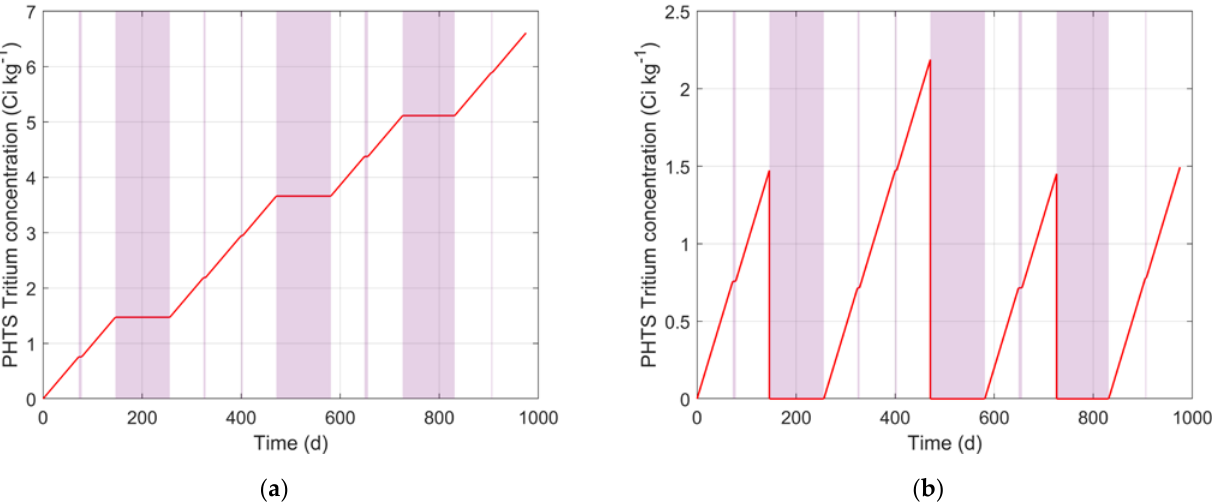
Figure 4. Increase of tritium concentration within primary coolant under assumed plasma operative sequence: ( a ) without CPS; ( b ) CPS off-line strategy, the whole PHTS water inventory is replaced with virgin water during in-vessel maintenance.